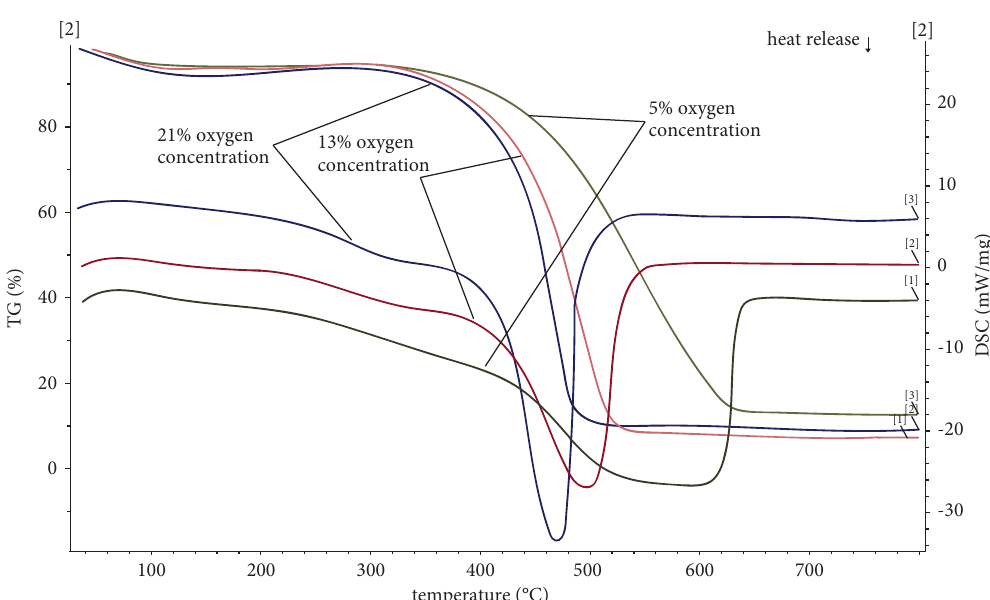
Figure 8: TG/DSC results for the Bulianta 12# raw coal sample at a heating rate of 10 ° C/min under O